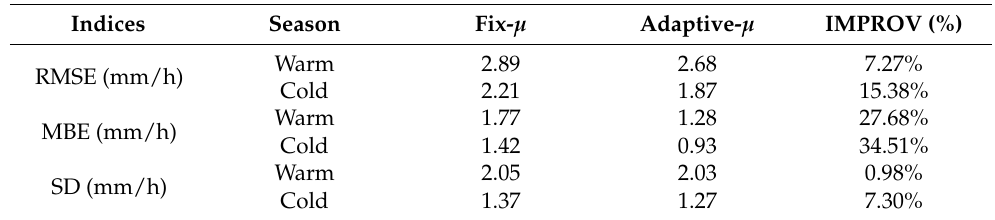
Table 4. Comparison of the fixed- and adaptive- µ model results in terms of RMSE, MBE, and SD indices for different seasons under the WDM6 scheme.